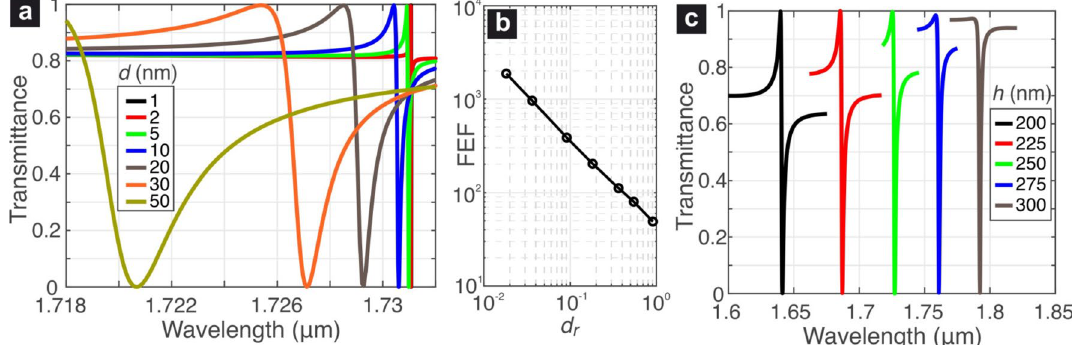
Figure 5. ( a ) Transmittance spectra in the vicinity of the AFMO quasi-dark resonance for h = 250 nm and various values of d and ( b ) corresponding local field-enhancement factors. ( c ) Transmittance spectra in the vicinity of the AFMO quasi-dark resonance for d = 30 nm and various values of h . Adjusting the Si thickness h allows for tuning the asymmetry of the Fano AFMO resonance without noticeably affecting its Q